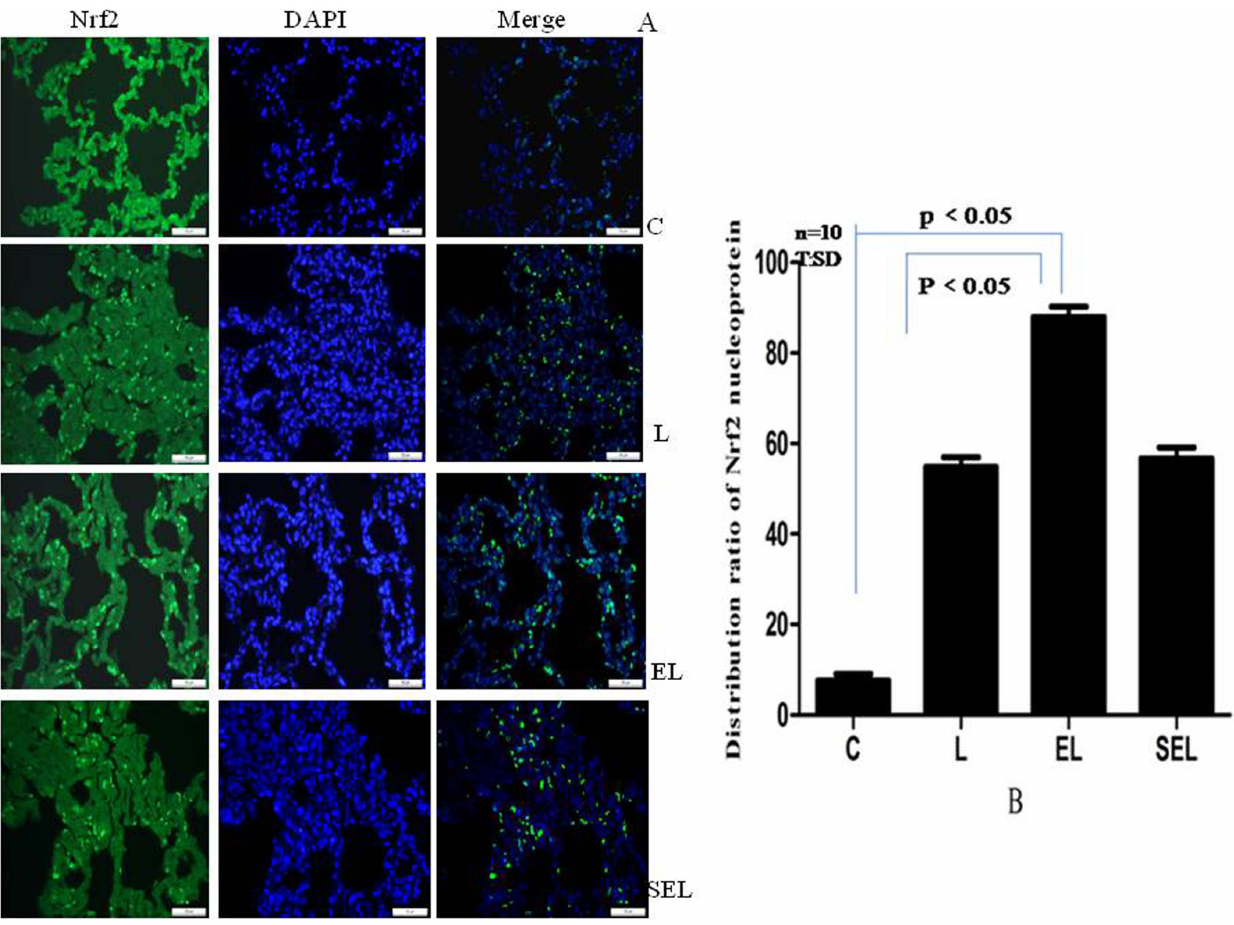
Figure 4. Immunofluorescence assays of nuclear localization of Nrf2 protein using fluorescence microscope (original magnification 6 400). ‘‘A’’ showed the pictures of immunofluorescence staining, while ‘‘B’’ presented the distribution ratios of Nrf2 nucleoprotein to the number of nuclei in unit area of five fields among four groups. Green standed for Nrf2-FITC stained sections, while blue standed for images of DAPI stained nuclei. It was confirmed that Nrf2 increasingly translocated from cytoplasm into the nucleus by electroacupuncture protocols ( P , 0.05 ) rather than sham electroacupuncture stimulation ( P . 0.05 ). Data were representative of three independent experiments. Values were mean 6 SD, and ten control, LPS, EL and SEL experiments were performed for each group.